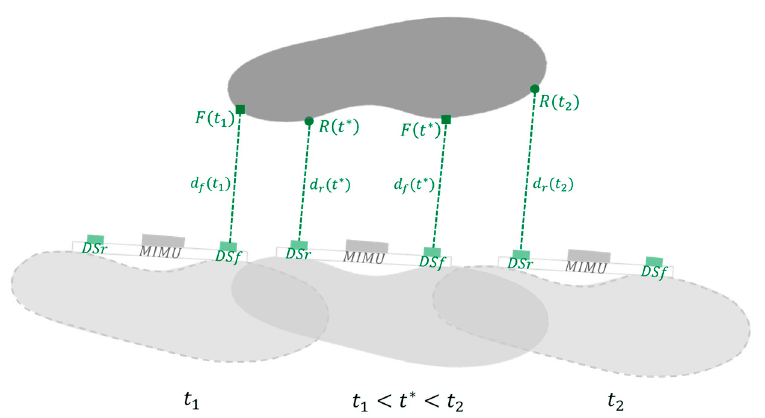
Figure 6. The instrumented foot (light grey) is in swing phase and faces the non-instrumented foot (dark grey), which is still during its stance phase. Between t 1 and t 2 , the front and rear distance sensors (DS f and DS r ) record distances d f ( t ) and d r ( t ) by detecting points F( t ) (green squares) and R( t ) (green dots) of the medial side of the non-instrumented foot.